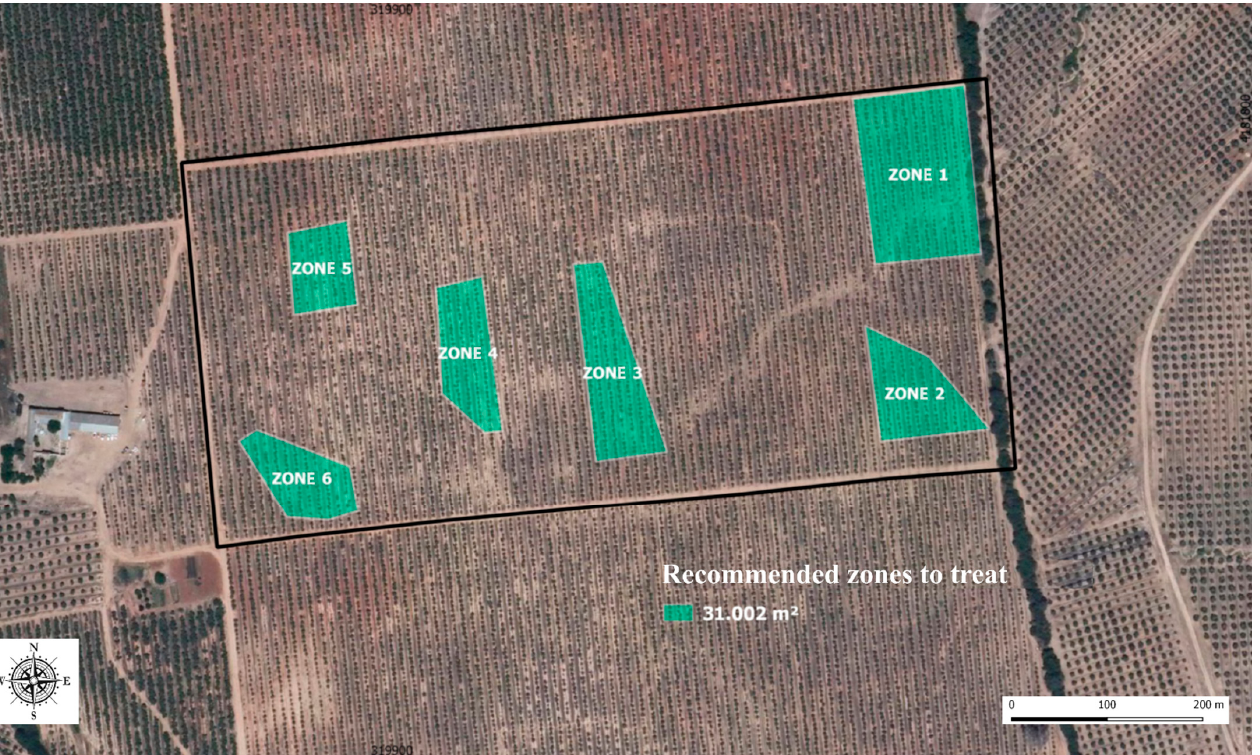
Figure 6. Vegetation index (VIs) maps generated through Parrot Sequoia (a multispectral camera) and Yuneec CGOET (a thermal sensor) mounted on Yuneec Typhoon H hexacopter RPA. ( A ) Crop area studied. ( B ) Map of “chlorophyll a” content based on NDRE. ( C ) Map for vegetation status generated based on NDVI. ( D ) Thermal map established using Yuneec CGOET. (Images facilitated by MCBiodrone).